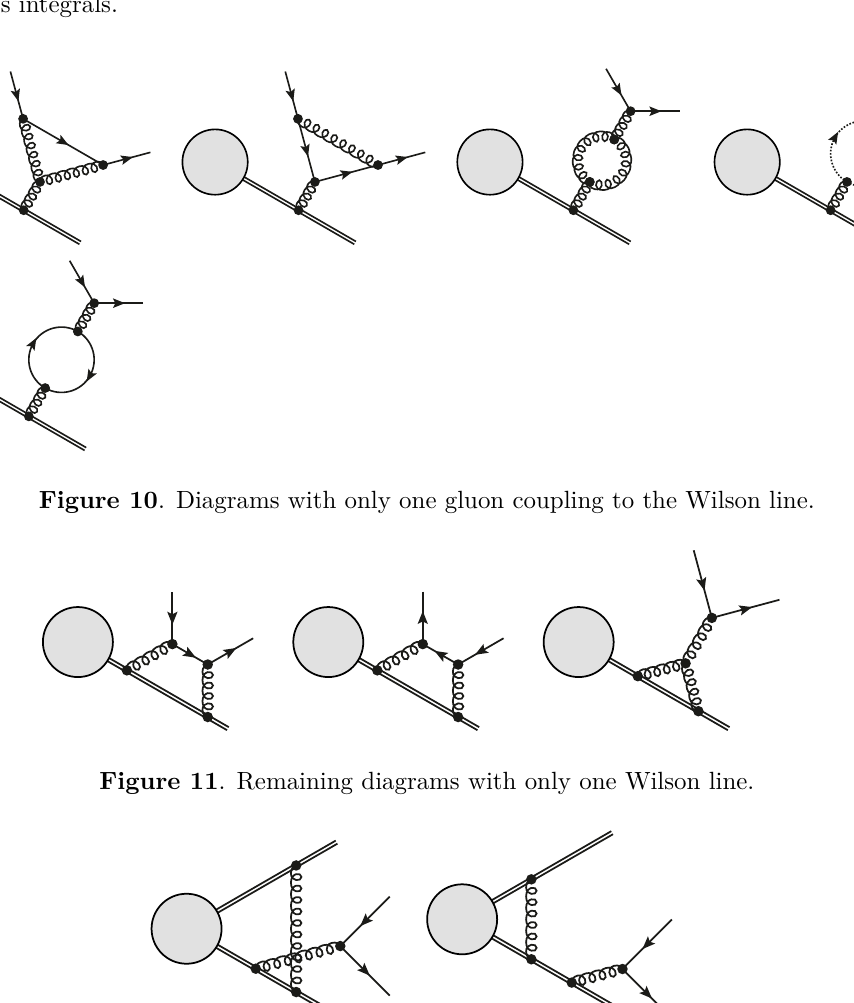
Figure 9 . Diagrams for soft quark-anti-quark pair emission with one Wilson line that correspond to scaleless integrals.